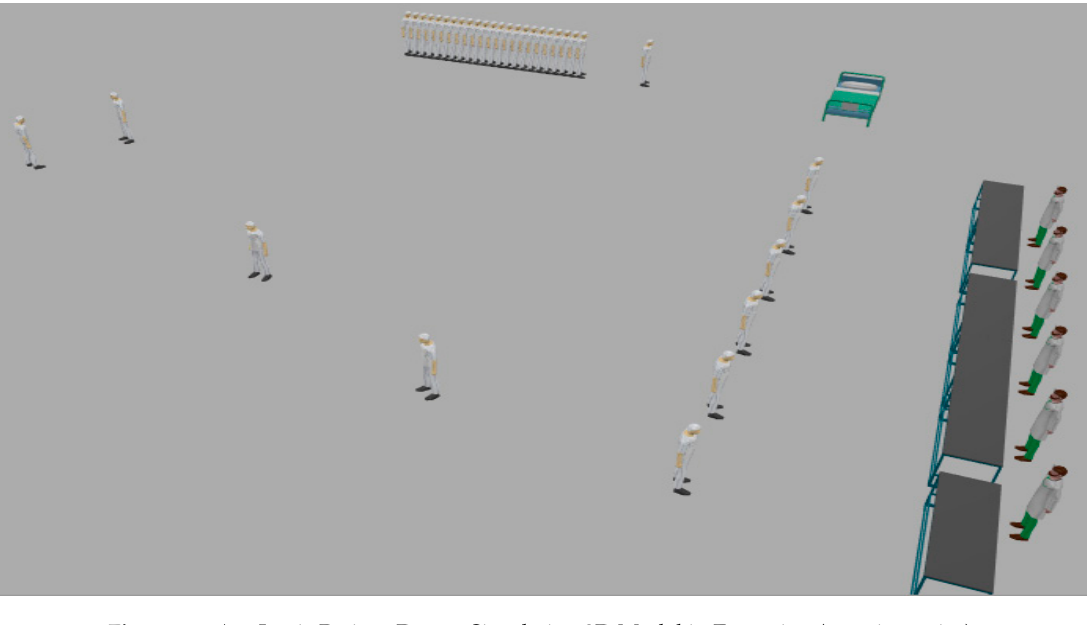
Figure 38. AnyLogic Patient-Doctor Simulation 3D Model in Execution (top viewpoint). Sensor 2020 , 9 , x FOR PEER REVIEW